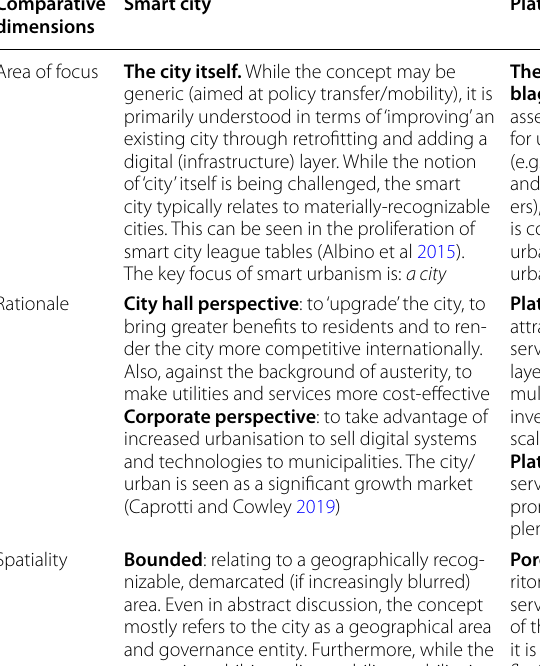
Table 1 Key differences between the smart city and platform urbanism Comparative Smart city Platform urbanism dimensions Area of